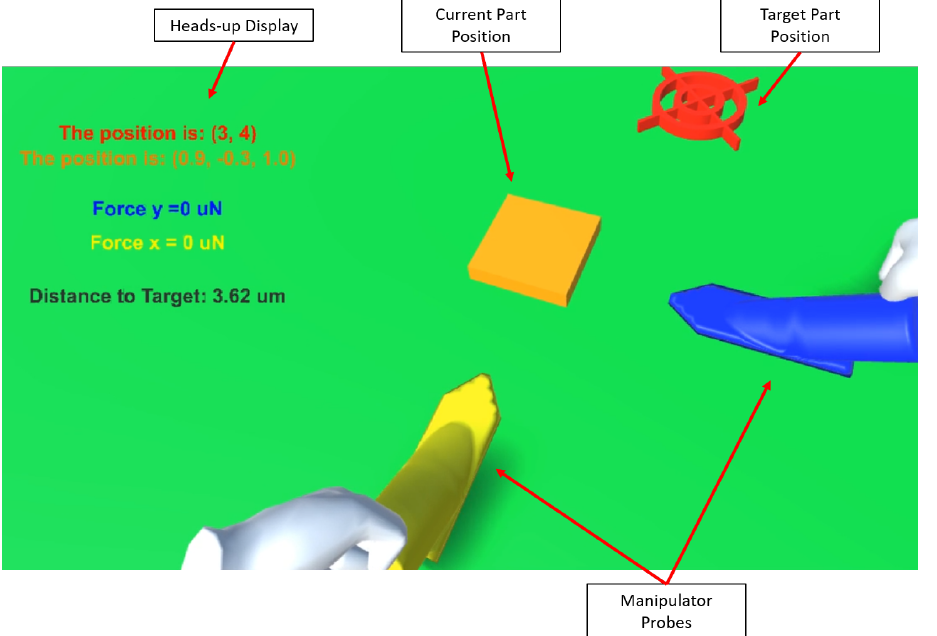
Figure 4. The VR scene as seen from the user’s point of view. The heads-up display shows important information to the user and it always remains on the top left side of the view. The part’s current and target positions are represented by the orange square and the red cross hairs,